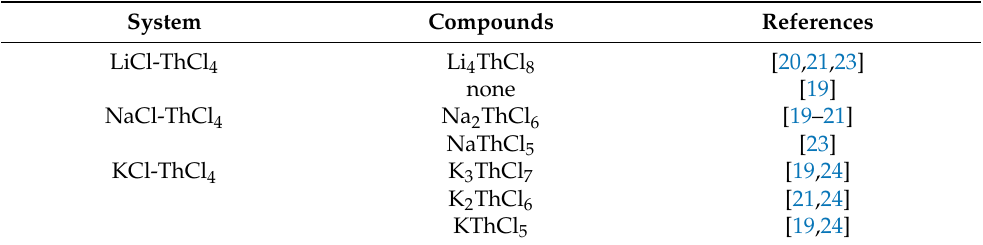
Table 1. Phases occurring in the alkali thorium chloride binary systems according to different sources. System